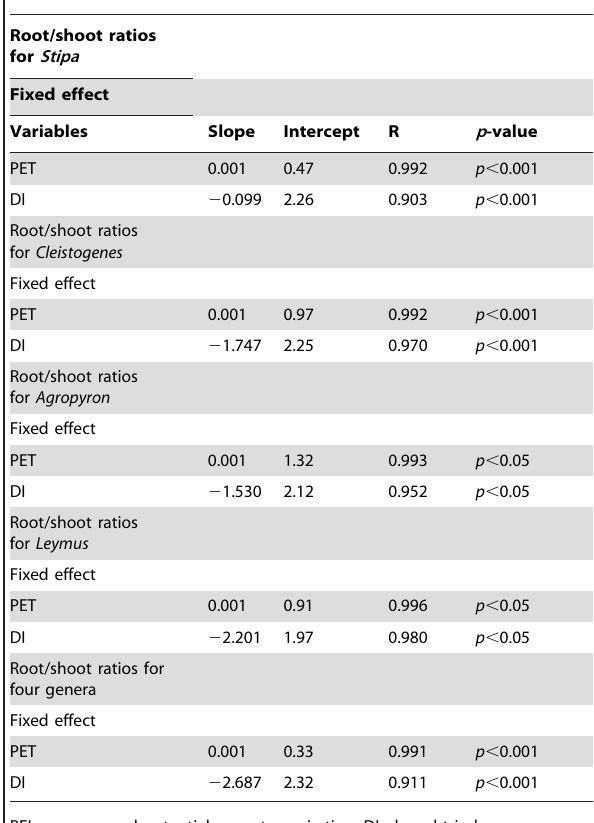
Table 5. Linear regression between above- and below- ground biomass for Stipa spp. , Cleistogenes spp. , Agropyron spp. , and Leymus spp. using a standardized major axis (SMA) method.